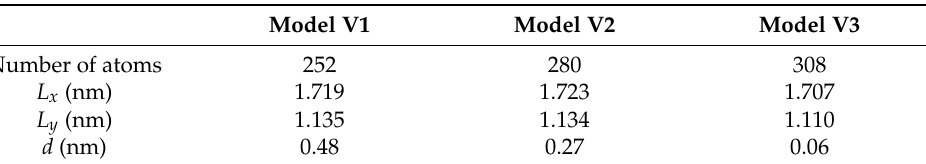
Table 1. Geometric characteristics of supercells of hybrid films formed by bilayer graphene and SWCNTs (12, 6).